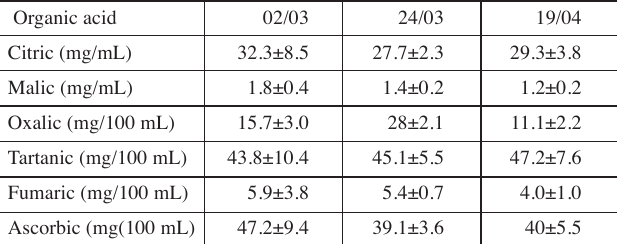
Tab. 2: Organic acid contents of Verna lemon fruit in different dates Organic